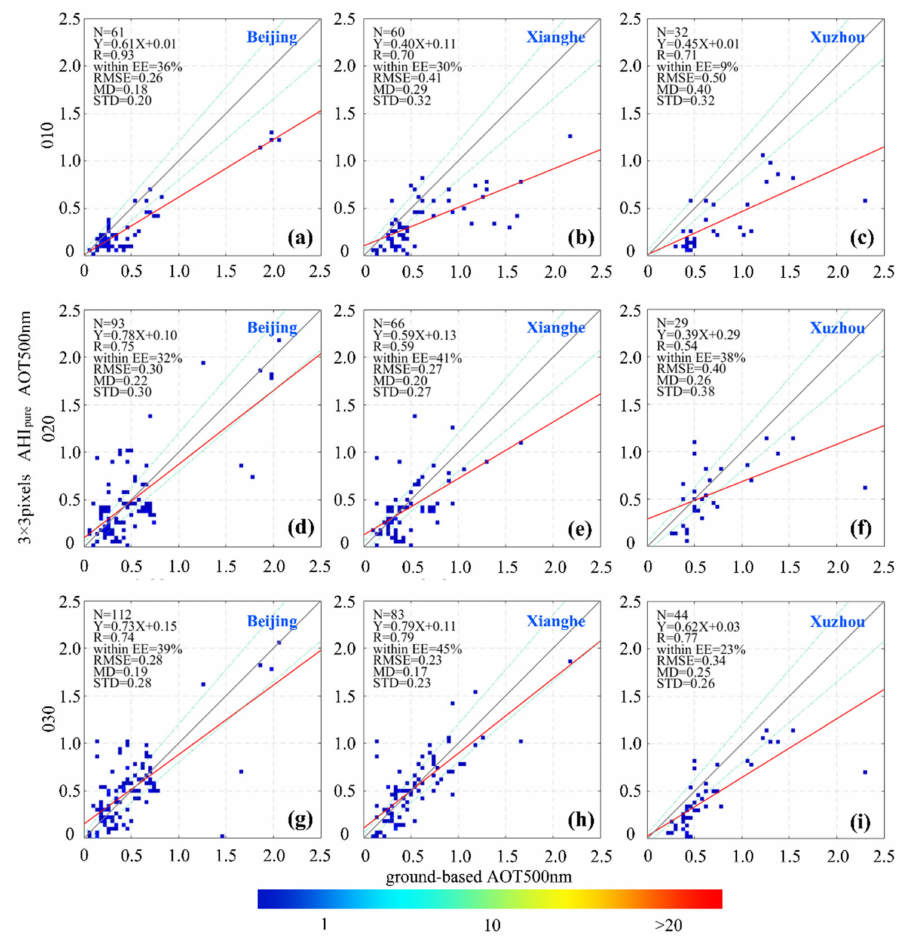
Figure 8. Scatterplots of the AOTs from three versions of H8 / AHI product against ground-based measurements. The three columns from left to right represent di ff erent sites and the rows from top to bottom represent version 010, 020, and